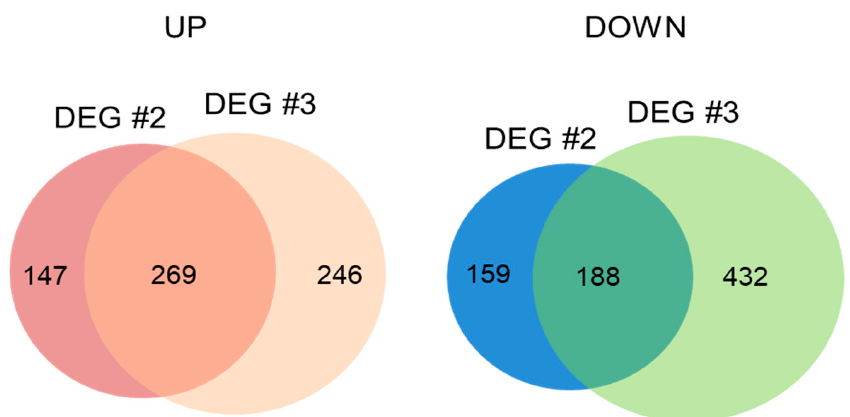
Figure 5. Venn diagram representing up- or down-regulated DEGs common to DEG #2 and DEG #3. The numbers represent significantly up- (left) and down- (right) regulated genes by HA in DEG #2 and DEG #3, indicating those regulated in common between DEG #2 and DEG #3. Among 188 genes down-regulated by HA in both DEG #2 and DEG #3, genes associ- ated with the “metabolic process” (GO:0008152) GO term were significantly enriched in